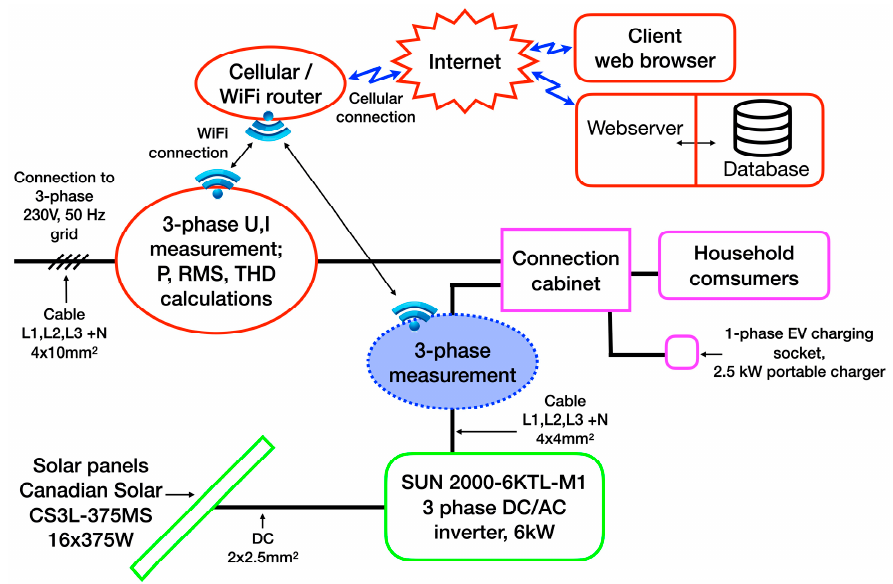
Figure 8. Upgraded measurement setup by the installation of an additional power meter.